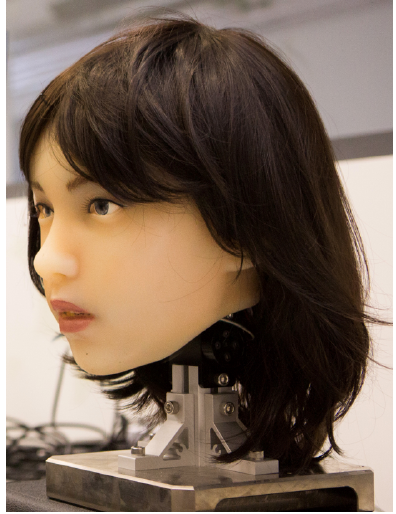
Figure 1: The Ever-4 (“EveR”)